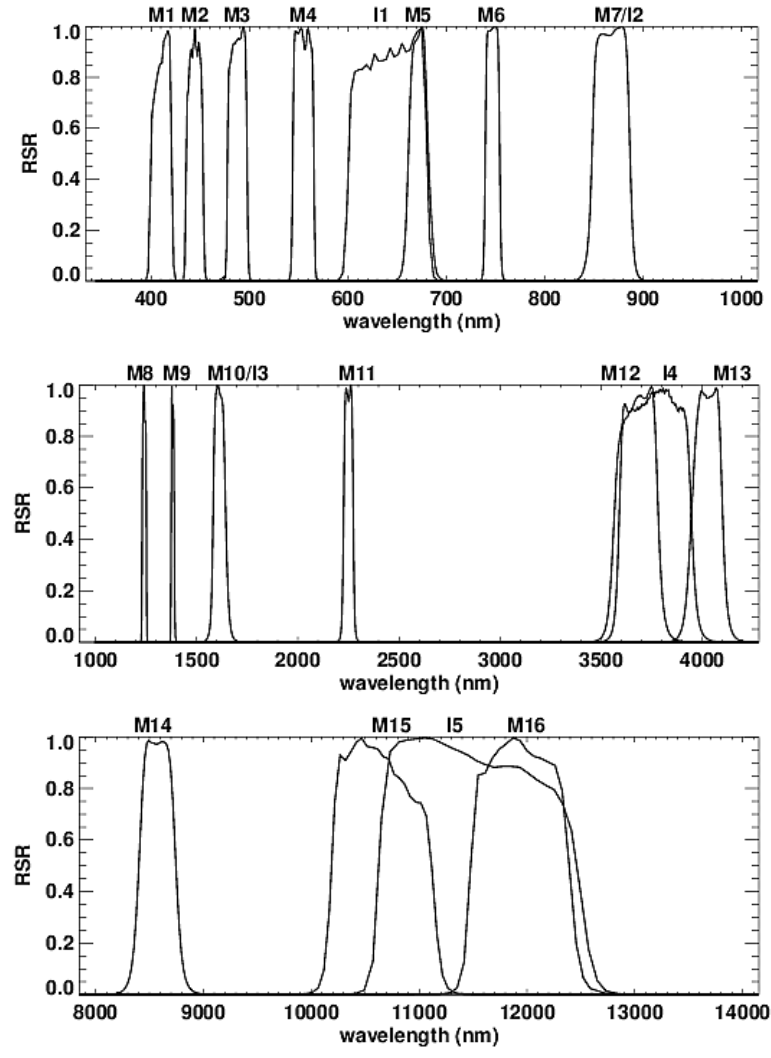
Figure 5. JPSS-3 VIIRS spectral bands RSR plotted versus wavelength, where the upper plot shows the VisNIR bands, the middle plot graphs the SWIR and LWIR bands, and the lower plot shows the LWIR